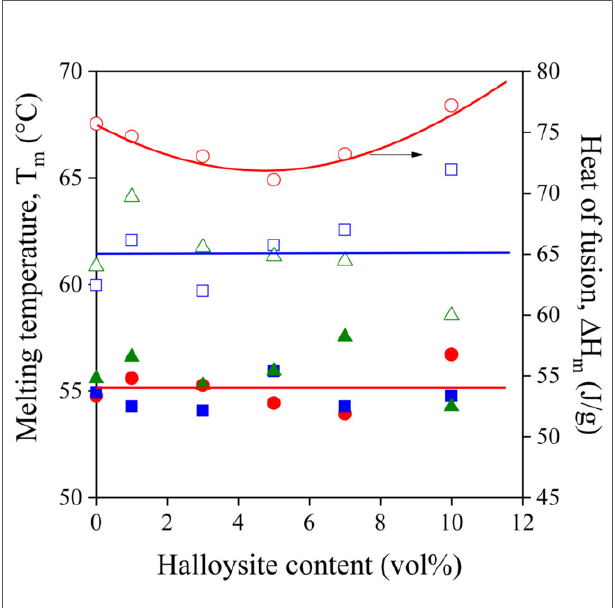
Figure 6. Melting characteristics of PCL halloysite composites plotted against halloysite content. Symbols: ( , • ) film, ( (cid:3) , (cid:4) ) compressed, ( (cid:52) , (cid:78) ) melt mixed. Full symbols: heat of fusion; empty symbols: melting temperature.